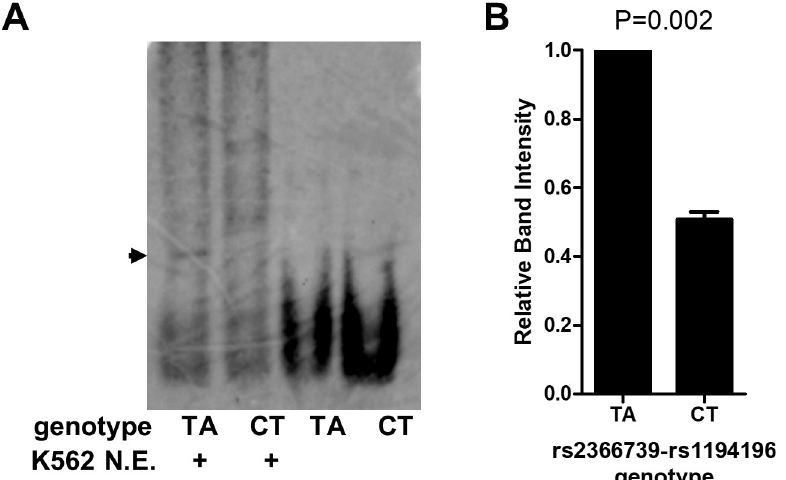
Fig 5. rs2355739-rs1194196 variants alter protein:DNA interactions. (A) Electromobility shift assay using probes containing 70bp of genomic sequence containing SNPs rs2355739 and rs1194196. Digoxin-labeled Probes were incubated with K562 cell nuclear extract where indicated, resolved by gel electrophoresis, and imaged with anti- digoxin antibodies. Arrow indicated specific complex formed by protein:DNA interactions. (B) Quantification of DNA:protein complex by densitometry. (N = 3) Significance by one-sample T-test.